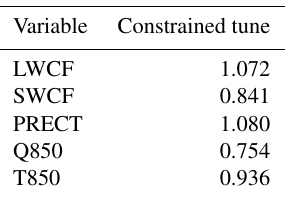
Table 4. Performance metric index of each variable in the optimal model run with unconstrained and constrained methods.